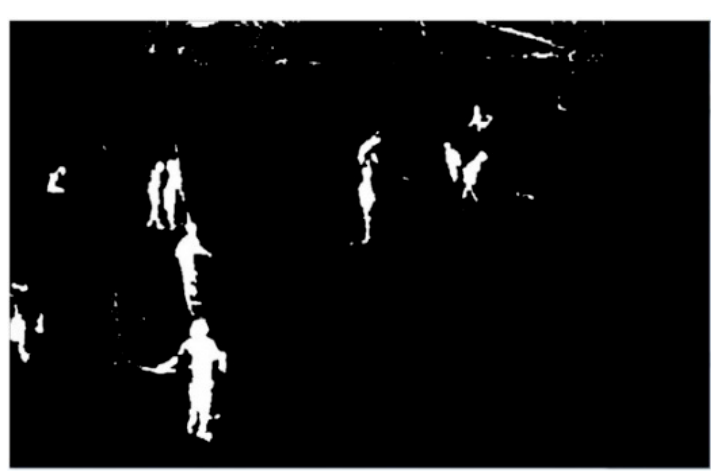
Figure 7. Morphological operation.